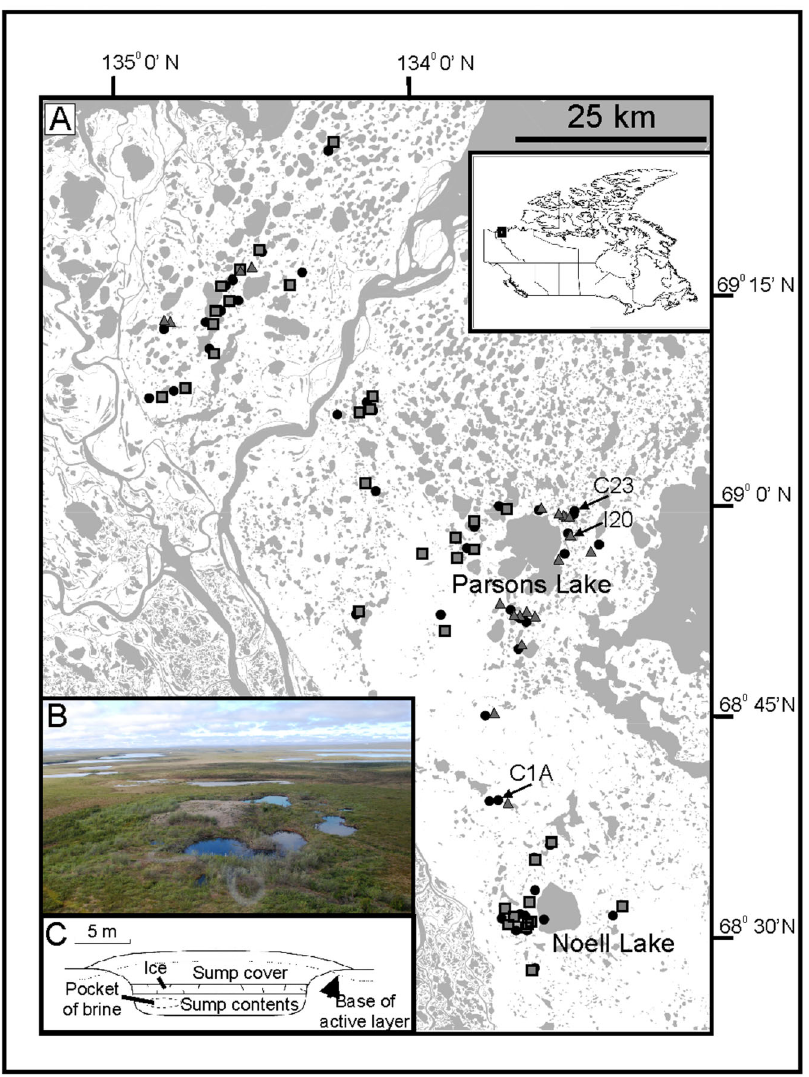
Figure 1. Map of study area, schematic of typical drilling sump and image of a degrading sump. A) The location of the 101 study lakes in the Mackenzie Delta uplands (Northwest Territories, Canada) (triangles – drilling-sump lakes; squares – thaw-slump lakes; circles – control lakes). Inset shows the region in the context of Canada. B) Image of a degrading drilling sump from the Mackenzie Delta uplands, near Parsons Lake, exhibiting significant surface and perimeter ponding. C) Generalized schematic of a drilling mud sump. A large pit is excavated into the permafrost and filled with the drilling wastes and fluids. These drilling fluids are then allowed to partially or completely freeze, and backfilled with the excavated material. The assumption is that the material will be permanently contained in the permafrost. Redrawn from